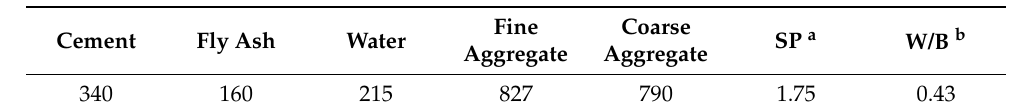
Figure 4. Details of the specimens: ( a ) plain concrete with no web reinforcement; ( b ) plain concrete with 0.3% web reinforcement; ( c ) fiber reinforced concrete with no web reinforcement. Table 2. Test matrix. Table 3. Mix proportions of SCC (kg/m 3 ).